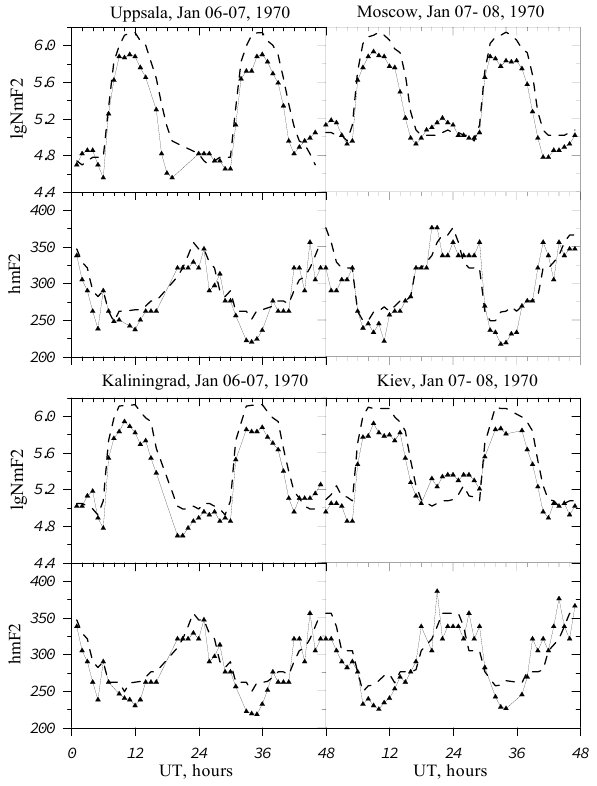
Fig. 3. Fig. 3. Observed diurnal Nm F2 and hm F2 variations at some Euro- pean stations during the 6–8 January 1970 negative Q-disturbance event. Dashes – a 27-day running median. Note that daytime hm F2 are below this median level.